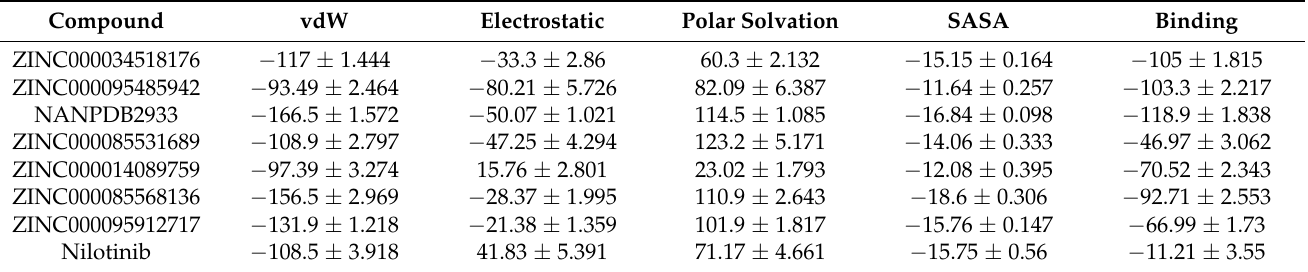
Table 3. Contributing energies of the VP40–ligand complexes estimated from MM/PBSA computa- tion. Values are presented as average energy value ± standard deviation in